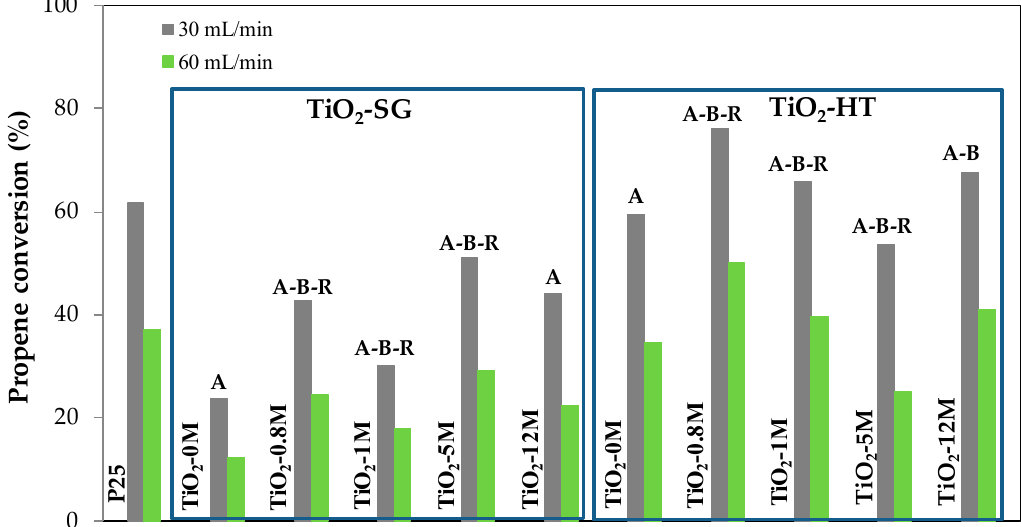
Figure 6. Propene conversion (%) at 30 and 60 mL/min for the SG and HT photocatalysts and for P25.